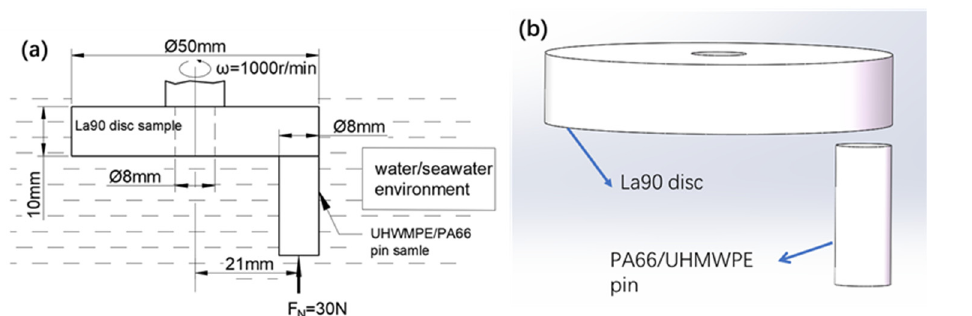
Figure 1. Contact diagram of aluminum alloy disc/UHMWPE (PIN): ( a ) Two-dimensional graph; ( b ) three-dimensional graph. Table 3. The composition of artificial Table 1. The properties of PA66 and UHMWPE.